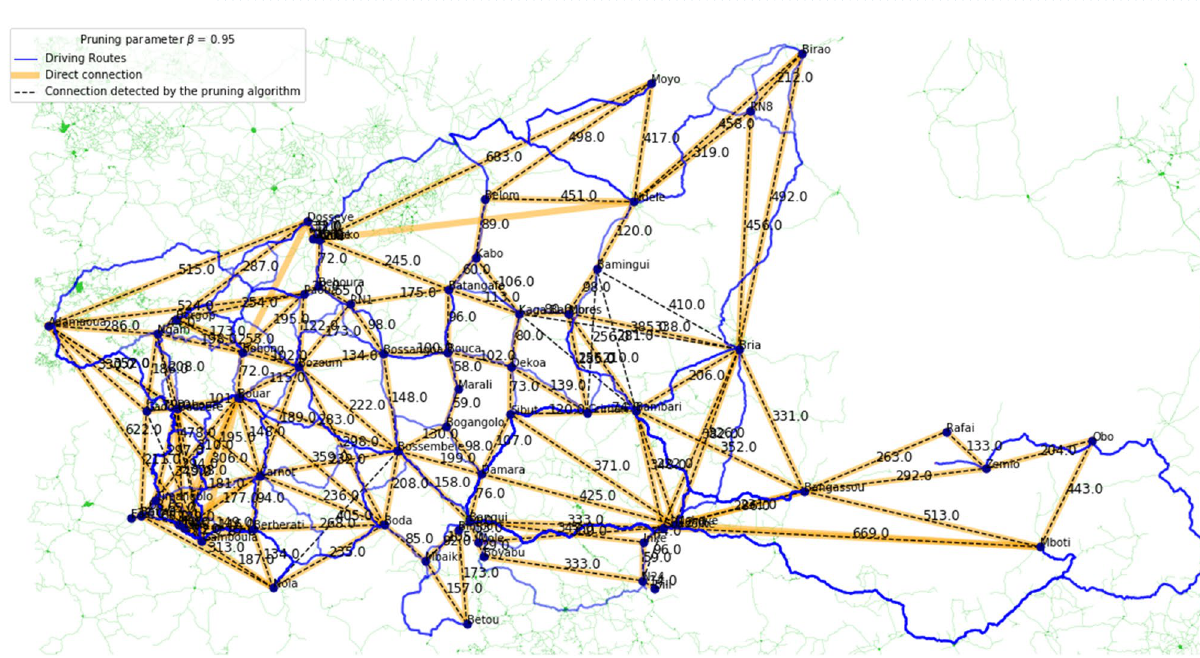
Figure 3. Connections of 23 locations in the border region between Germany and Austria with β = 0.95 .